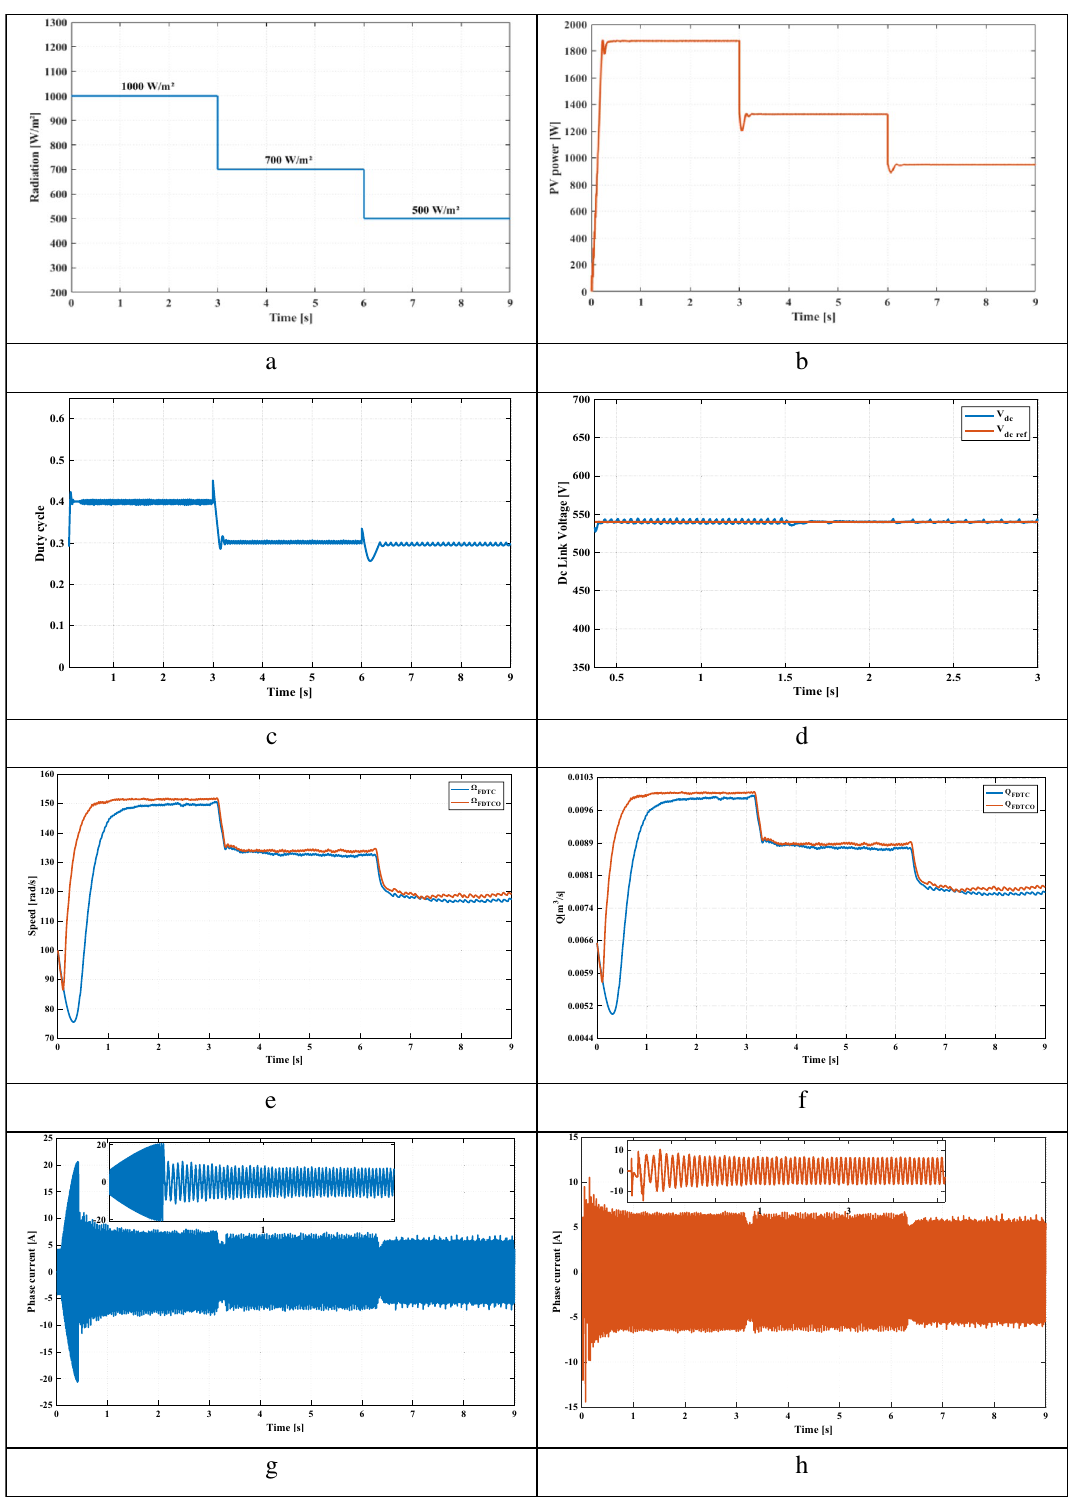
Figure 8. ( a ) Solar radiation ( b ) Extracted power ( c ) Duty cycle ( d ) DC link voltage ( e ) Rotor speed ( f ) Pumped water ( g ) Stator phase current of FDTC ( h ) Stator phase current of FDTCO ( i ) Flux response using FLC ( j ) Flux response using FDTCO ( k ) Stator flux trajectory using FDTC ( l ) Stator flux trajectory using